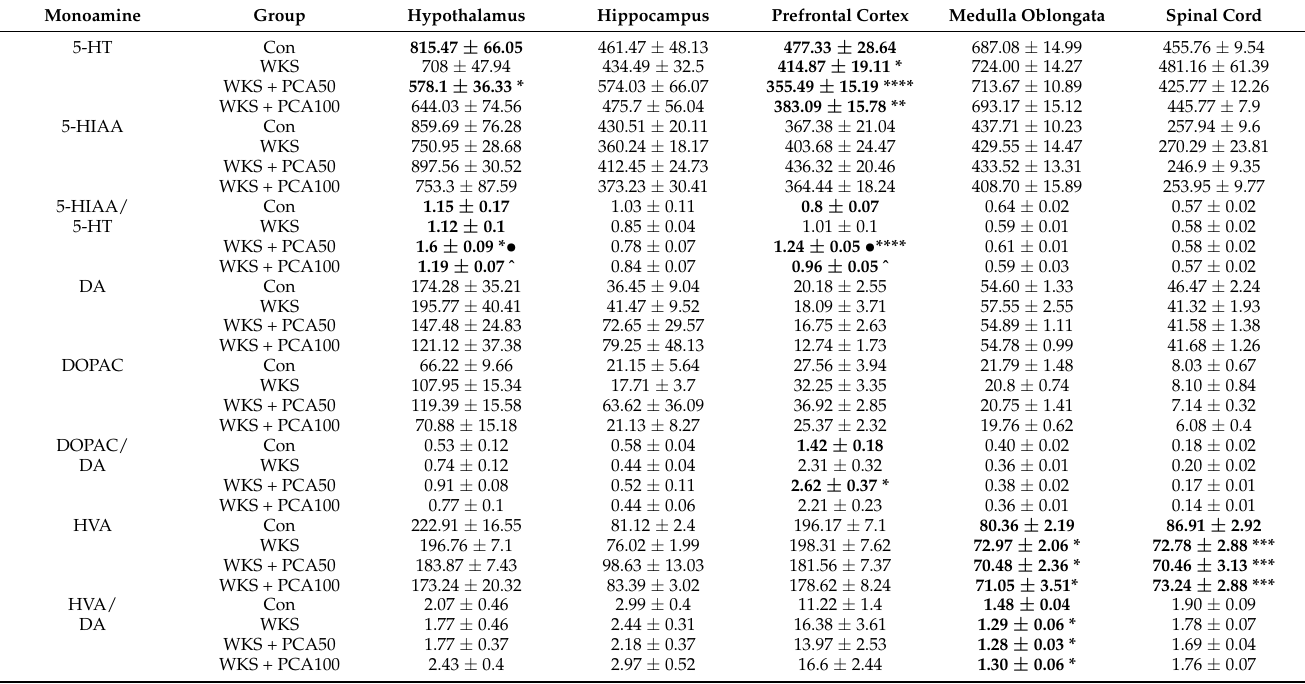
Table 3. Effect of long-term oral administration of PCA at doses of 50 mg/kg and 100 mg/kg on the level of monoamines, their metabolites (mean ± SEM) (ng/g of tissue) and the turnover (-) in selected brain regions in the PTD model of WKS in